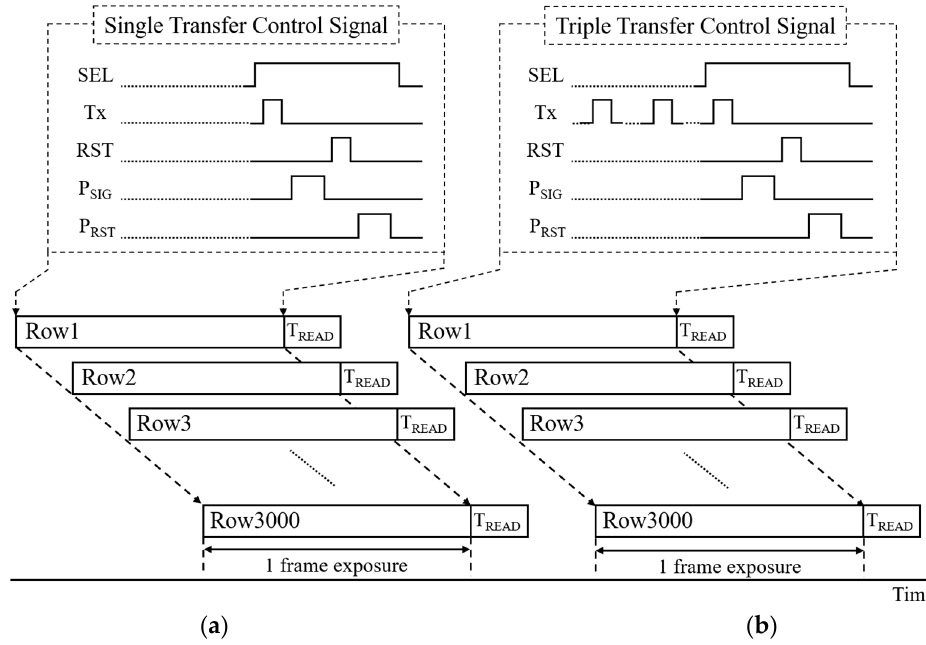
Figure 4. Timing diagram: ( a ) Single charge transfer; ( b ) Multiple charge transfer.